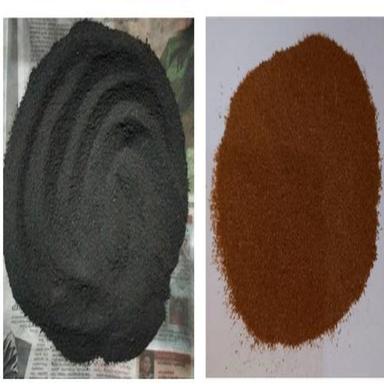
Copper slag granules and Coconut fibre powder.